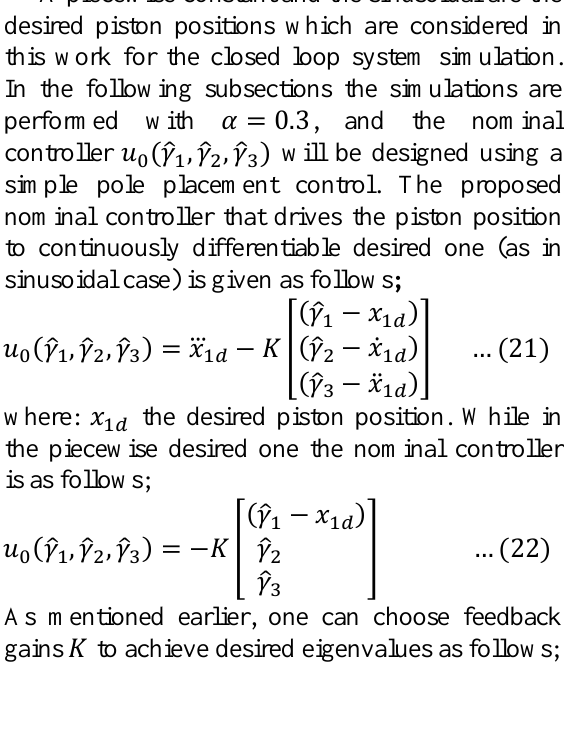
(cid:159) = (cid:160). £